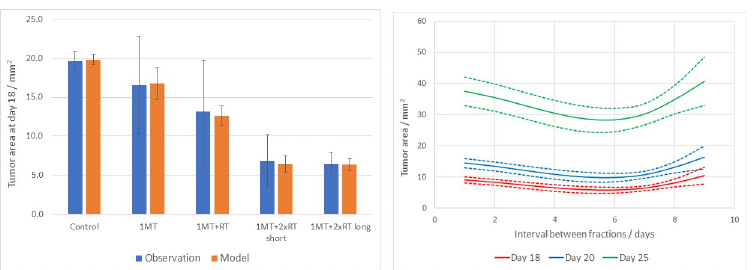
Fig 3. A) Mean tumor size upon euthanasia in the five treatment groups, shown by blue bars. Tumor size was significantly decreased in the animals treated with 1-MT+radiotherapy x 2. Orange bars represent model-fitted values. Y-axes represents the tumor area in mm 2 . Error bars indicate 1SD. B) Curves representing the cross-sectional area at selected time periods post inoculation as generated by the fitted model. Dashed lines indicate